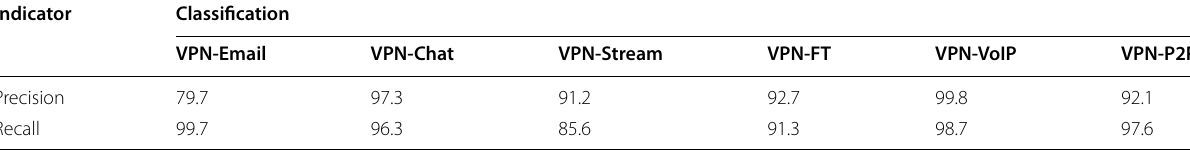
Table 4 Accurate experimental precision and recall for the encryption category of Experiment 3 Indicator